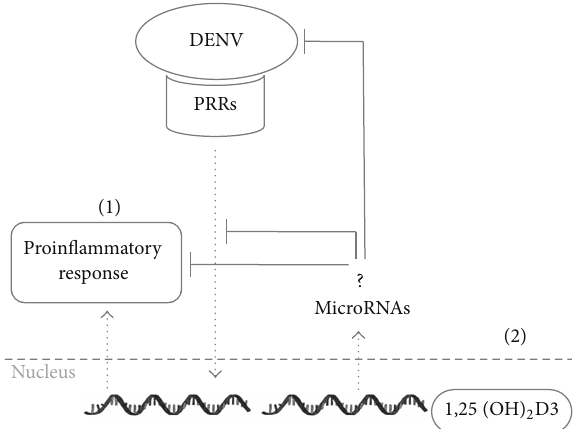
Figure 1: Potential link between vitamin D and miR controlling DENV-induced inflammatory response and antiviral activity. (1) DENV replication products and proteins are recognized by several PRRs whose signaling pathways promote the proinflammatory response. (2) Vitamin D activity induces transcription of microR- NAs and other target genes that play a critical role in the control of inflammation-related signaling pathways and antiviral